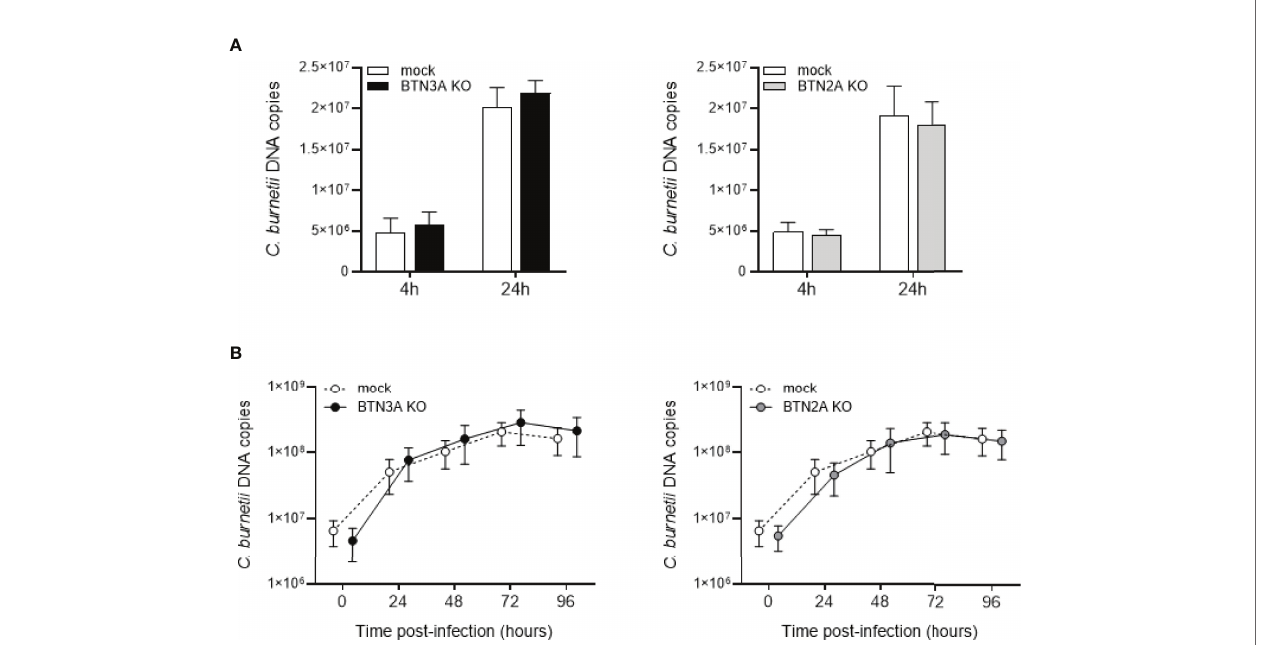
FIGURE 2 | Involvement of BTN3A and BTN2A in C. burnetii infection. CRISPR-Cas9-mediated inactivation of BTN3A or BTN2A was performed in THP-1 cell line. THP-1 cells transduced with a guide targeting all BTN3A isoforms (BTN3KO) or all BTN2A isoforms (BTN2AKO) or with an irrelevant CRISPR guide (mock) for control cells were infected with C. burnetii NM1 (50 MOI) (n = 3). (A) After 4 and 24 hours of infection, the number of bacterial DNA copies within THP-1 cells was assessed by qPCR. (B) THP-1 cells were incubated with C. burnetii for 4 h (day 0), then washed to eliminate free bacteria and incubated for 4 days. Each day, the number of bacterial DNA copies was evaluated by qPCR. Values represent mean ± standard